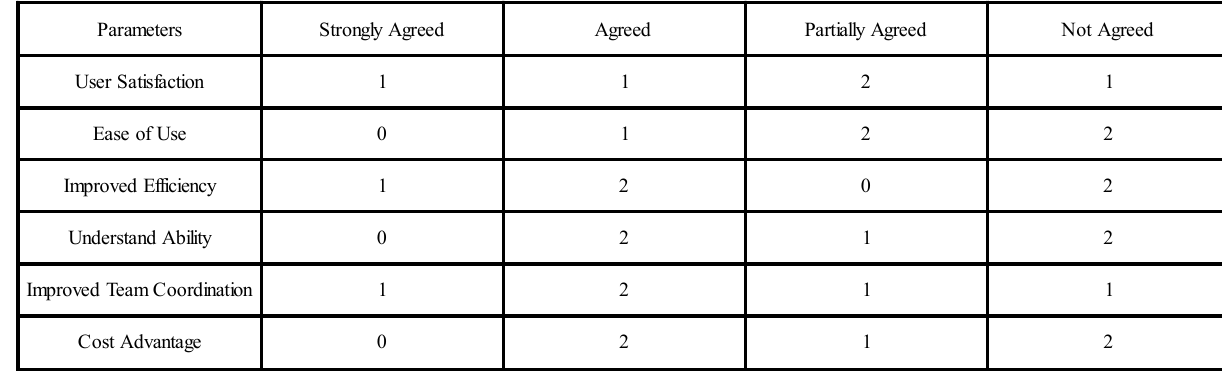
TABLE 3. MANTISBT